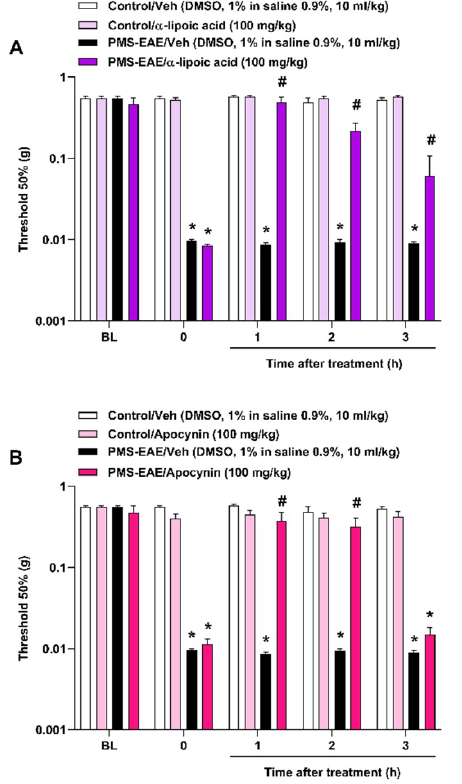
Figure 4. The intragastric treatment with α -lipoic acid and apocynin attenuated periorbital mechanical allodynia (PMA) in the progressive multiple sclerosis model induced by experimental autoimmune encephalomyelitis (PMS-EAE) in mice. The administration of ( A ) α -lipoic acid (100 mg/kg) or ( B ) apocynin (100 mg/kg) intragastrically (i.g.) was performed on day 14 post-induction (p.i), and their antinociceptive effects were observed from 1 up to 3 h. The vehicle group received dimethyl sulfoxide (DMSO) 1% in isotonic saline 0.9% i.g. Baseline values (BL) were observed before PMS-EAE induction. Data are expressed as mean + SEM ( n = 6–8) in the graphs. * p < 0.05 when compared to the control group or baseline values; # p < 0.05 when compared to the PMS-EAE group treated with the vehicle (Veh) (Two-way ANOVA followed by Bonferroni’s post hoc test).